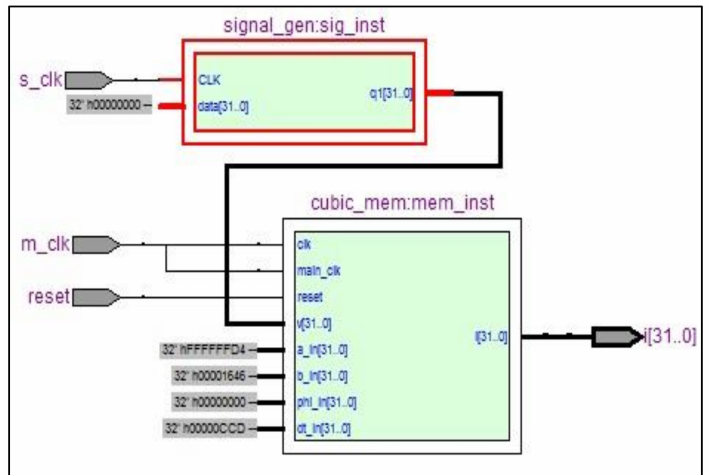
Figure 9. FPGA memristor emulator RTL